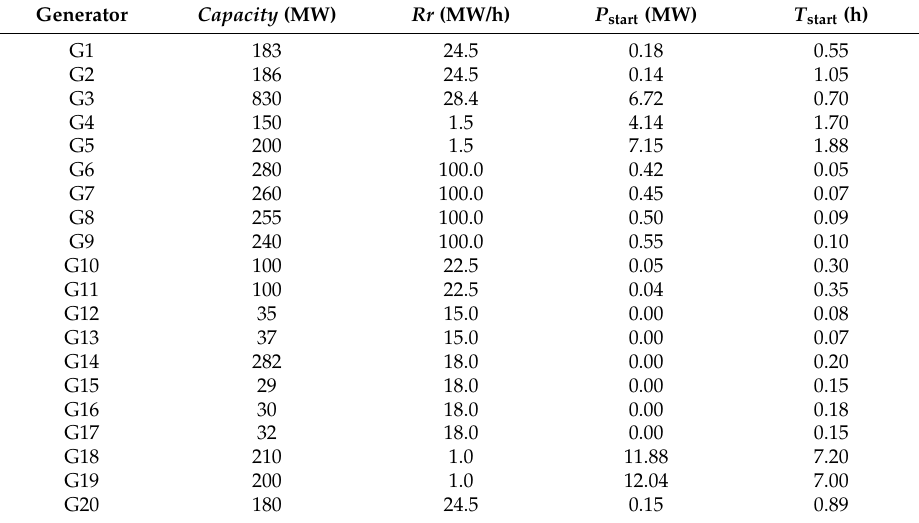
Table 1. Information about the generators in the eastern regions.